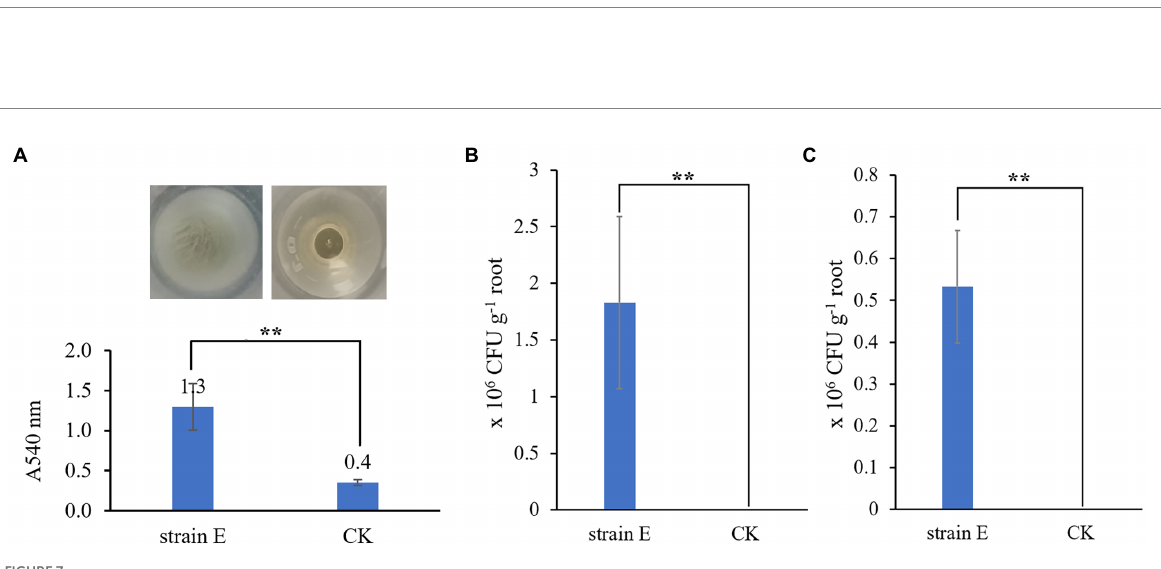
FIGURE 7 Assays of colonization and biofilm formation of strain E (A) Evaluation of the biofilm-forming capacity by crystal violet staining. LB broth was used as a control. Epiphytic (B) and endophytic (C) colonization of GFP-labeled strain E on the lily root. Sterile water was used as a control. Asterisks indicate statistically significant differences according to Duncan’s multiple range test. (** p <